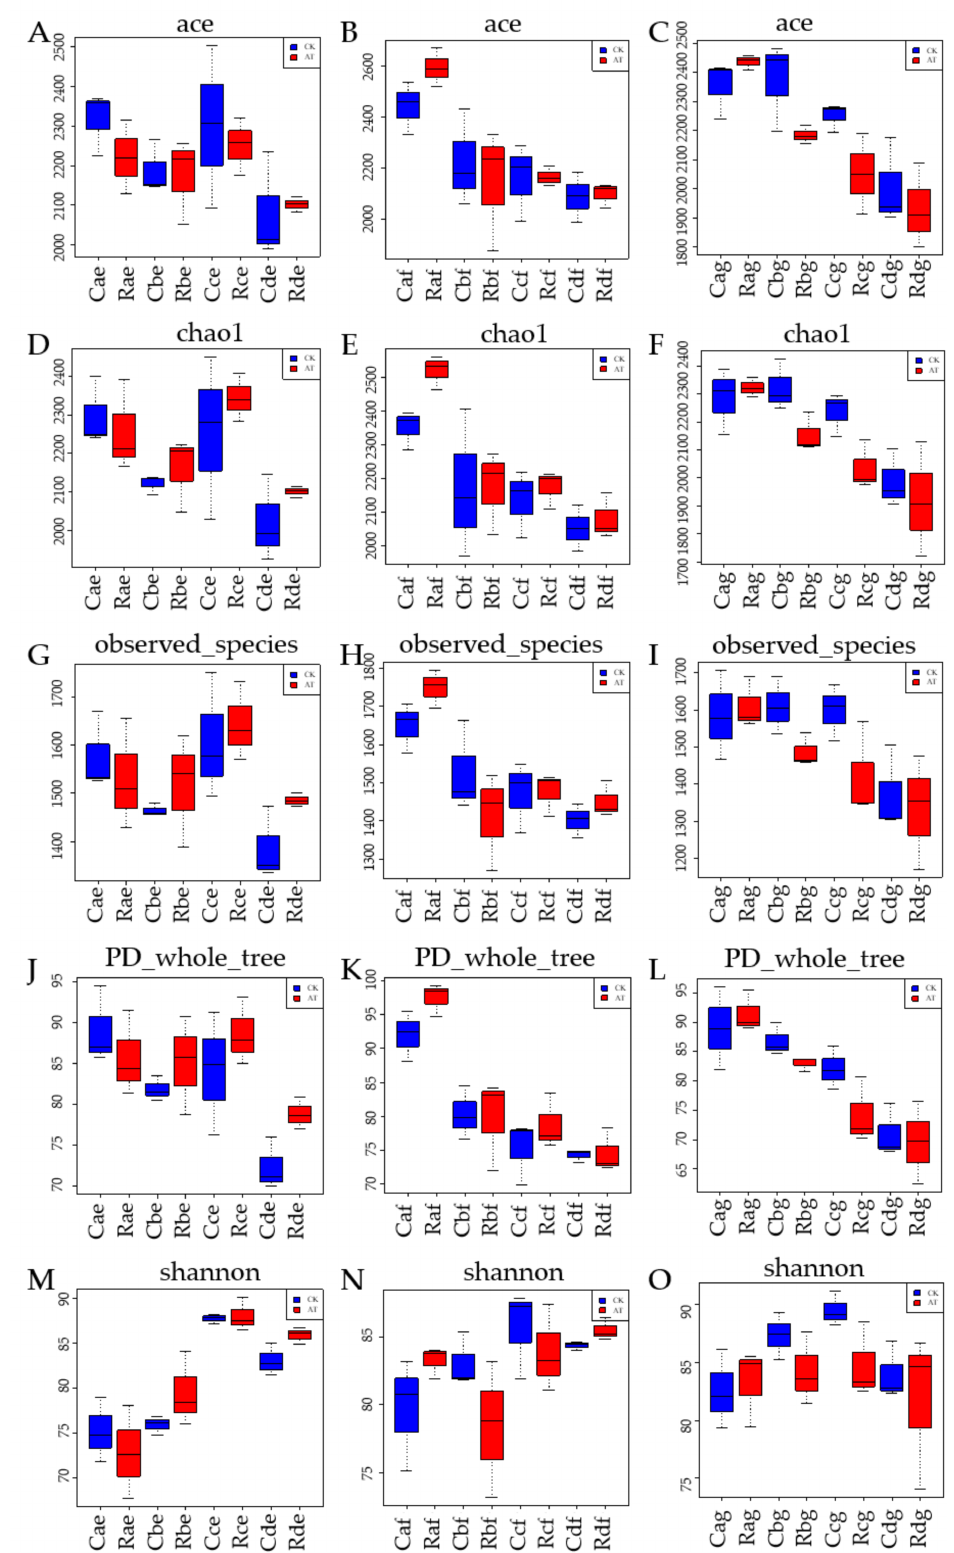
Figure 6. Variation of alpha diversity in different soil layers of atrazine-contaminated soil. ( A , D , G , J , M ) 0–10 cm; ( B , E , H , K , N ) 10–20 cm; ( C , F , I , L , O ) 20–30 cm. Each value represents mean ± SD ( n = 3). R, C indicate atrazine in AT and CK, respectively, at recommended dose; a, b, c, d indicate soil samples at 1, 7, 21, and 119 d, respectively; e, f, g indicate 0–10, 10–20, and 20–30 cm soil level,